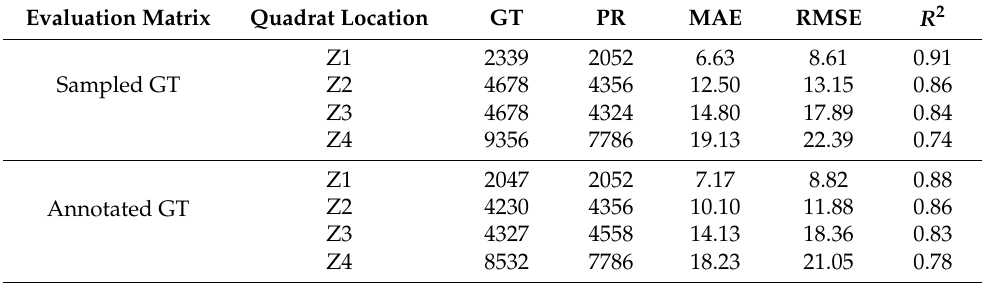
Table 6. The influences of zenith angle on model